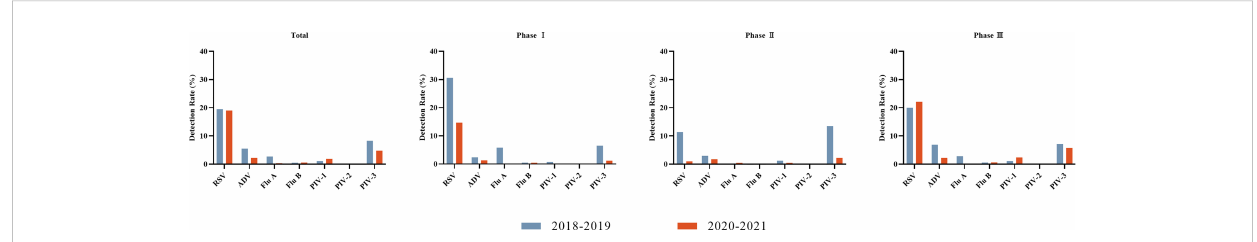
FIGURE 1 Detection rates of viruses before the COVID-19 pandemic (2018 – 2019) and during the COVID-19 pandemic (2020 – 2021) for each of three phases. Seven respiratory viruses were included: respiratory syncytial virus (RSV), adenovirus (ADV), in fl uenza virus A and B (Flu A, Flu B), and parain fl uenza virus types 1 – 3 (PIV1 – 3).